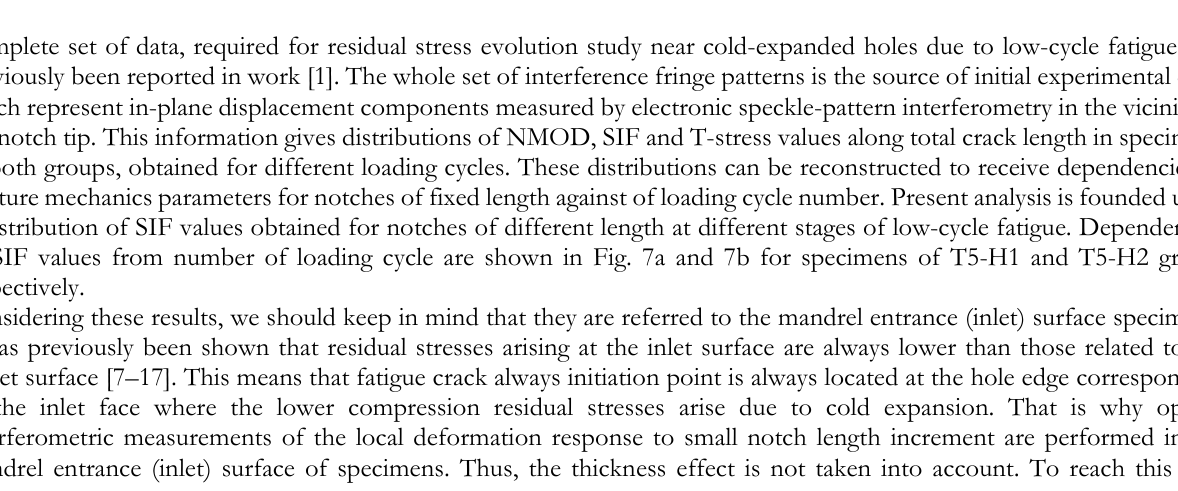
Figure 6: Average values of NMOD .  